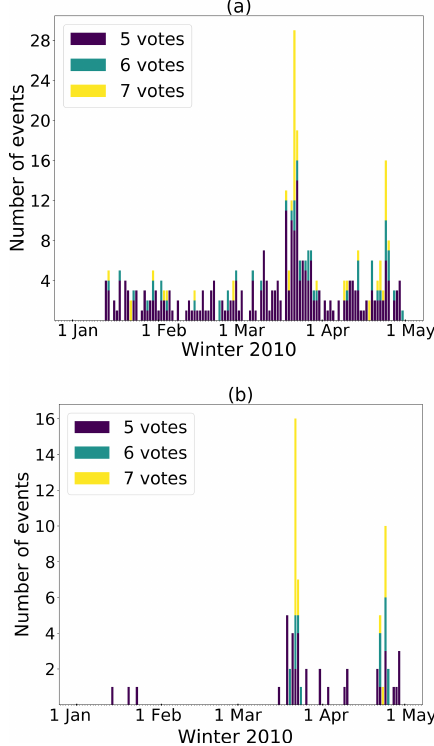
Figure 13. All events detected by at least five sensors. The different colors indicate the number of votes. (a) The results without any lim- itation of the duration of the events are plotted. (b) Only events with a minimum duration as mentioned before are taken into account. On the right the two main avalanche periods are more clearly